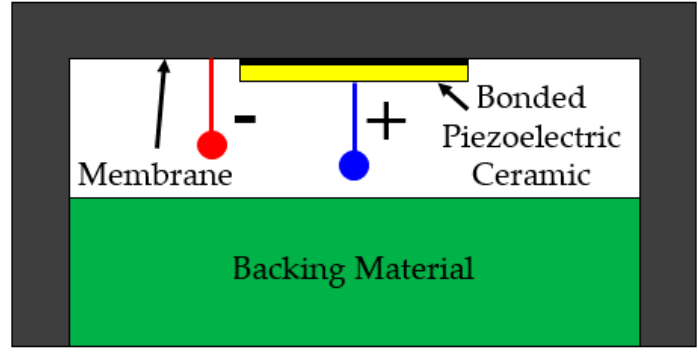
Figure 1. A generalized schematic of a conventional flexural ultrasonic transducer (CFUT), where the backing material is typically silicone.